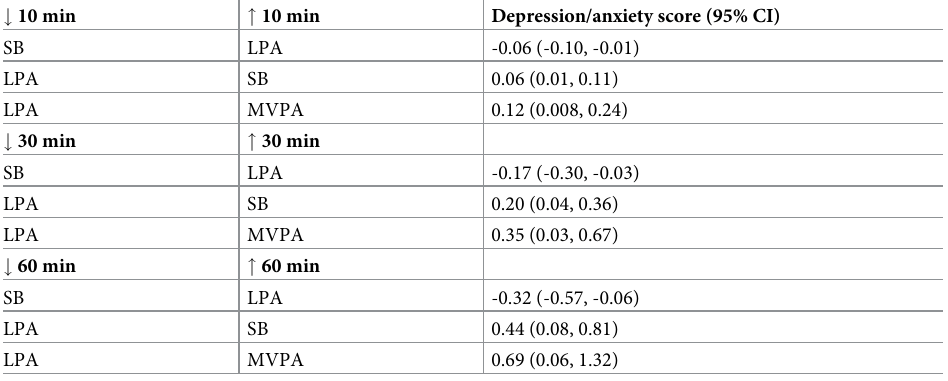
Table 4. Predicted changes in the depression/anxiety score associated with the reallocation of 10, 30, and 60 min between movement behaviors. # 10 min " 10 min